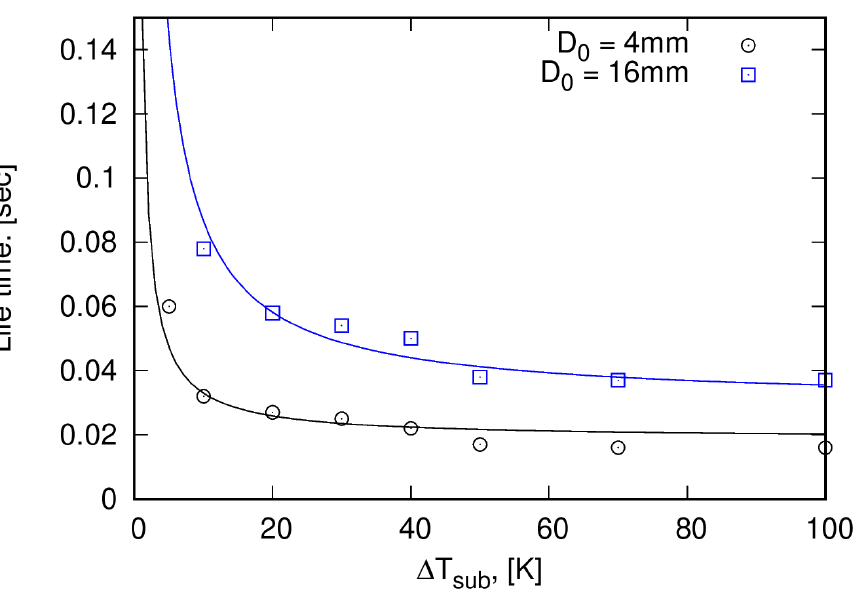
Figure 6. The vapor bubble lifetime at different subcool temperatures; points correspond to the numerical simulations (Tanasawa model), solid lines are plotted based on Equation (12) , where the fitting coefficients are f 1 =32,440 W/m 2 K and f 3 = 0.12 s/m 1/3